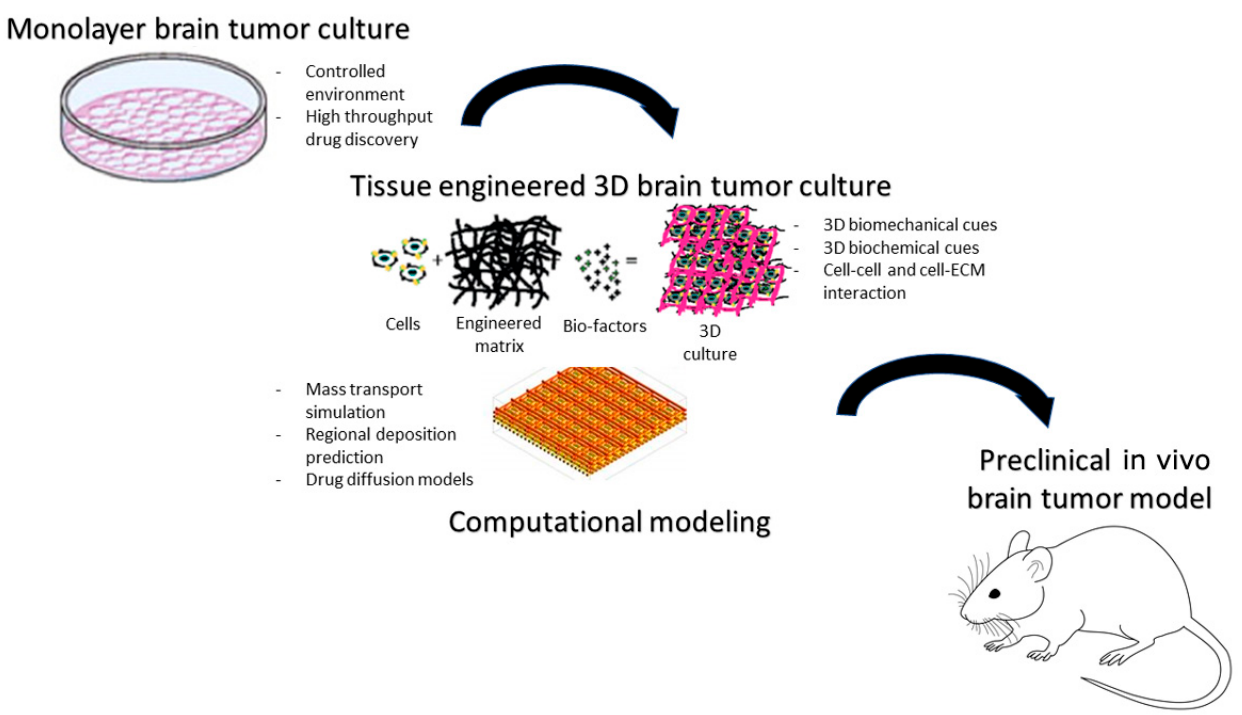
Figure 5 . In vitro/in silico predictive brain tumor models identify candidate therapeutic compounds for preclinical drug delivery assessment (original figure).